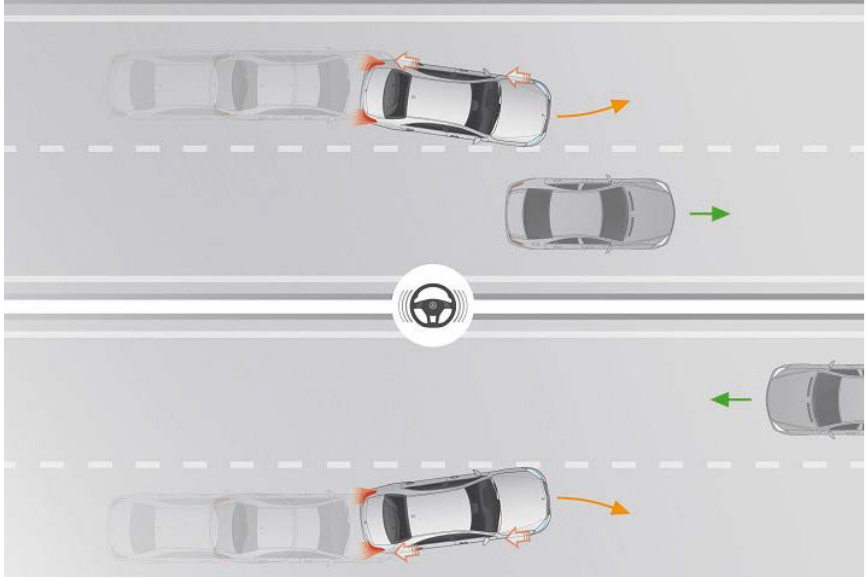
Figure 2. Lane ‐ keeping assistant system maintaining a vehicle position in the lane [31]